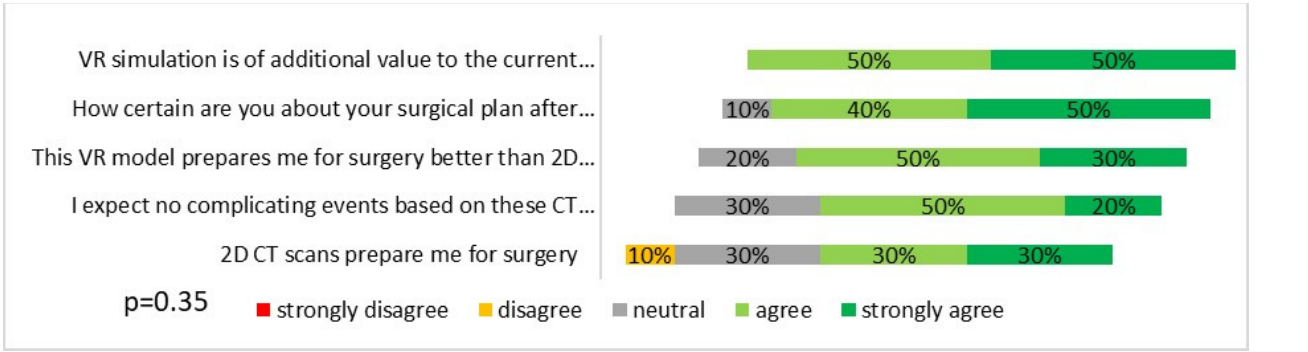
Figure 2. Questionnaire results of participating surgeons on the effectiveness of virtual reality software and hardware for the preoperative planning of ascending aortic surgery.